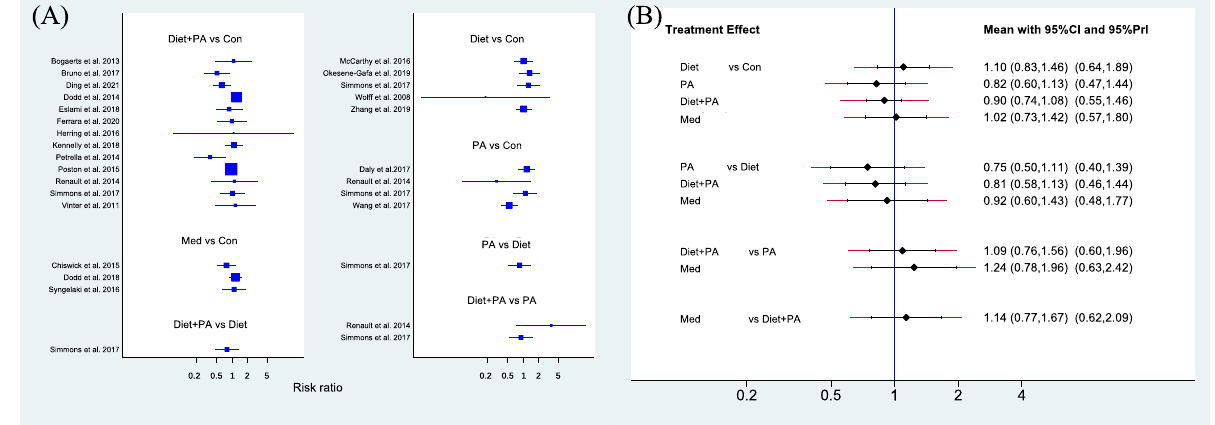
Figure 3. Network forest plot of direct pairwise comparisons of regimens ( A ), and of both direct and indirect comparisons of regimens ( B ) on the incidence of GDM. Abbreviations: physical activity, PA; control, Con; medication, Med [5,8,13–18,21–26,29–36].